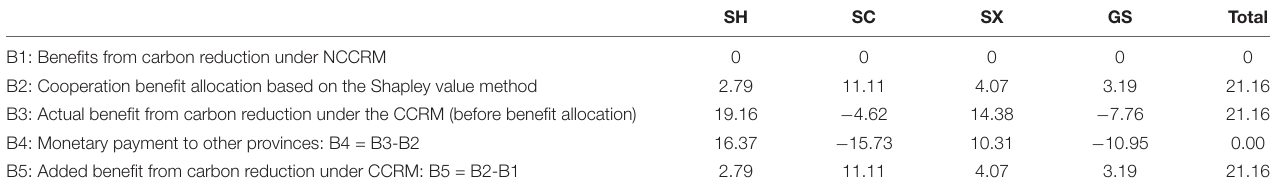
TABLE 8 | Allocation of benefits from cooperative carbon reduction (10 8 CNY).